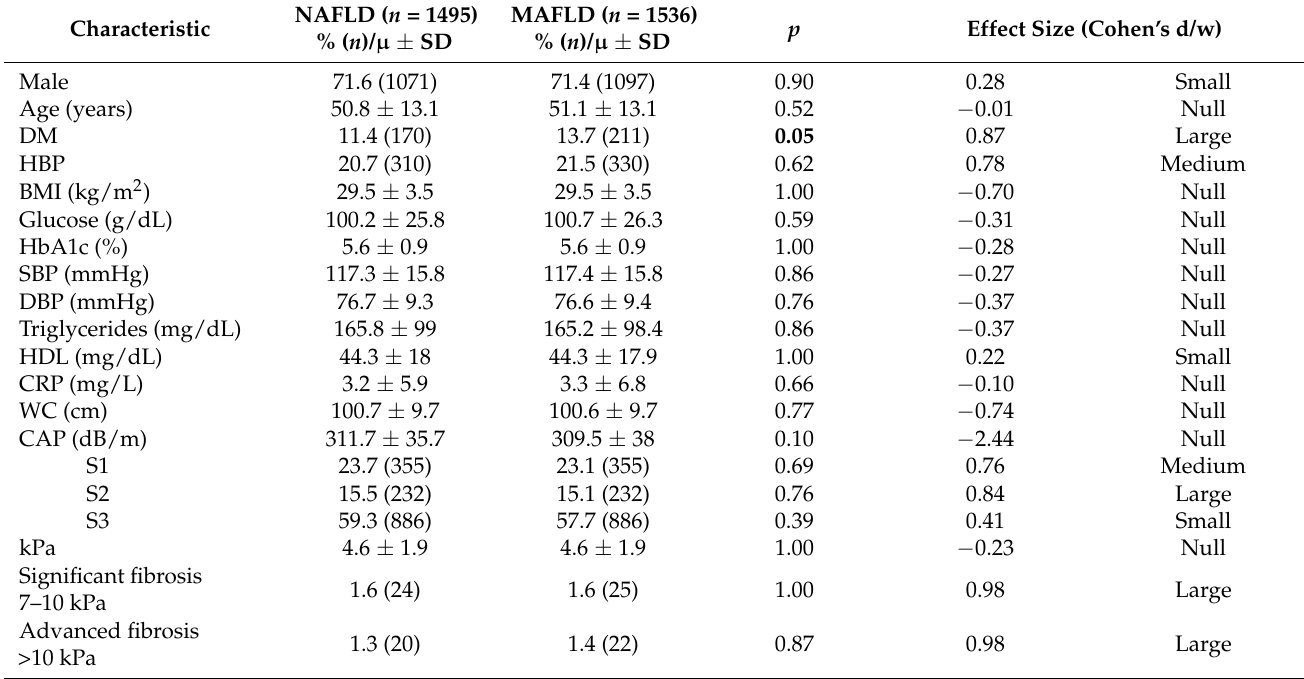
Table 2. Differences in clinical and demographic characteristics of NAFLD and MAFLD criteria in patients with BMI ≥ 25 kg/m 2 ( n =